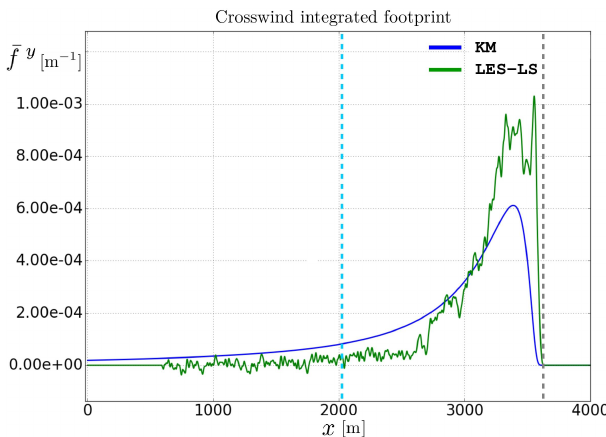
Figure 9. Comparison of normalized, crosswind integrated LES– LS and KM footprints. A light blue dashed line indicates the start of urban topography and the gray dashed line marks the location of the EC